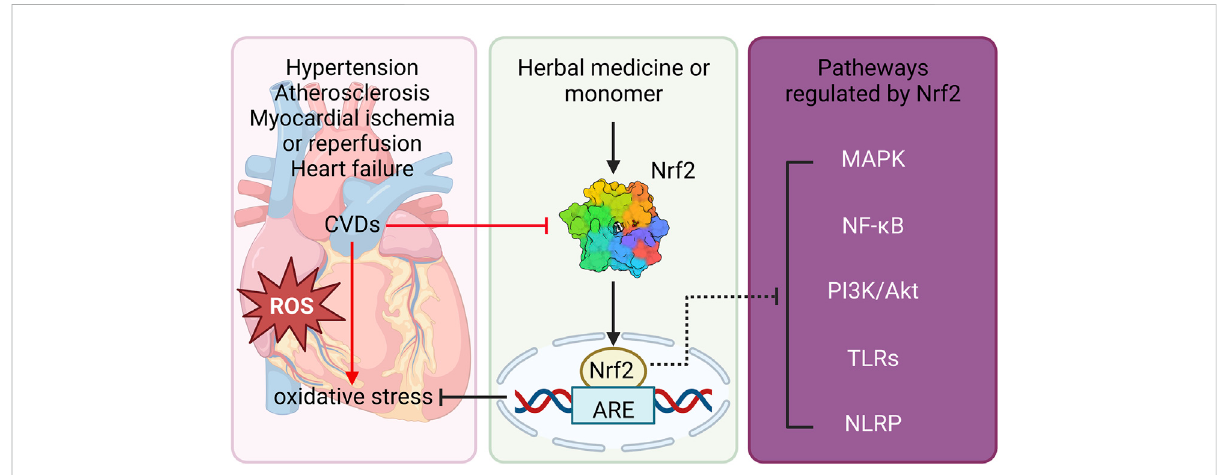
FIGURE 2 Schematic diagram of natural product-mediated activation of Nrf2 against CVDs. Natural products protect against CVDs including hypertension,atherosclerosis, myocardialischemia,heartfailure via reducingOS.Furthermore,thebene fi cialeffectsofnaturalproductsonCVDs,at least partly, through activation of Nrf2 and its downstream ARE, as well as modulation of other signaling pathways including MAPK, NF- κ B, PI3K/Akt, TLRs and NLRP signalings. Nrf2, nuclear erythroid 2-related factor 2; CVDs, cardiovascular diseases; OS, oxidative stress; ARE, antioxidant response element; MAPK, mitogen-activated protein kinase; NF- κ B, nuclear factor kappa-light-chain-enhancer of activated B cells; PI3K, phosphatidylinositol-3-kinase; AKT, protein kinase B; TLRs, toll-like receptors; NLRP, NOD-like